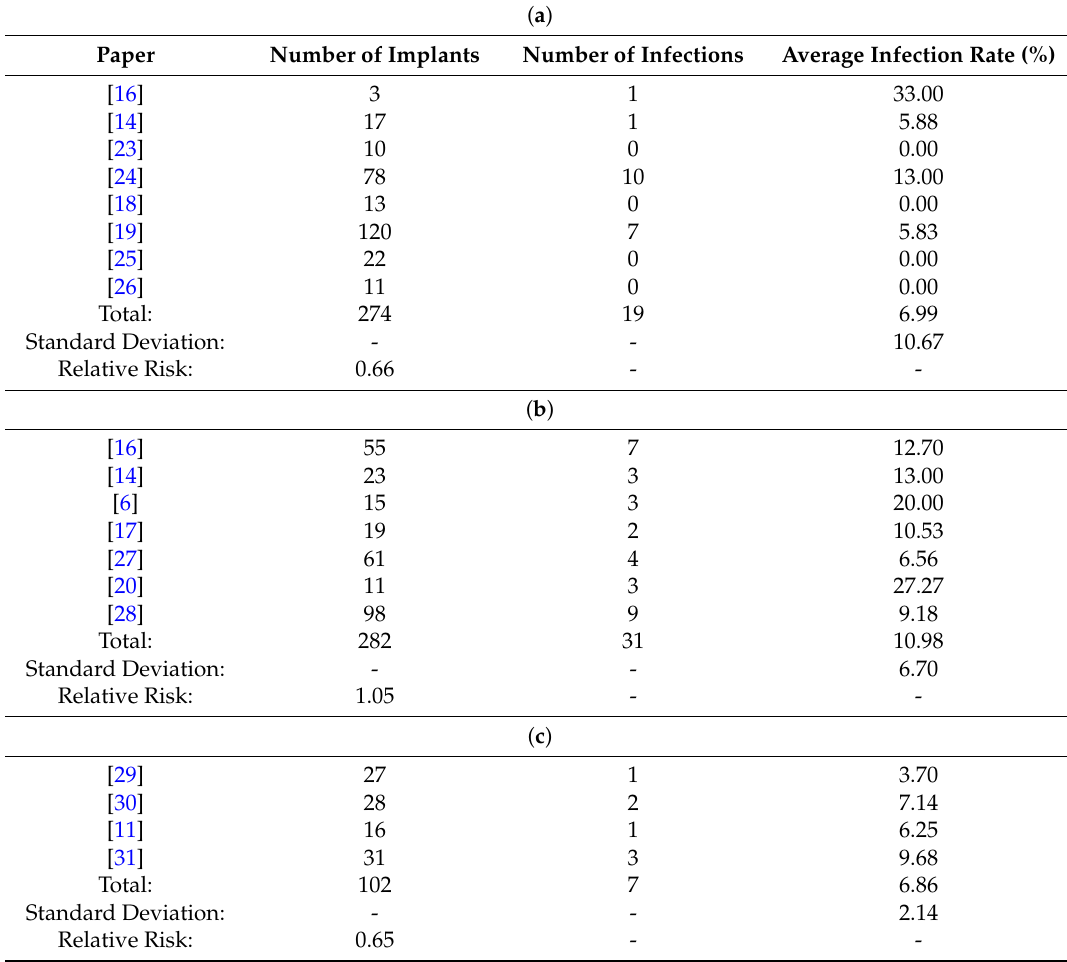
( a ) PMMA (Prefabricated); ( b ) PMMA (Hand-formed); ( c ) PMMA (Templated). PMMA: